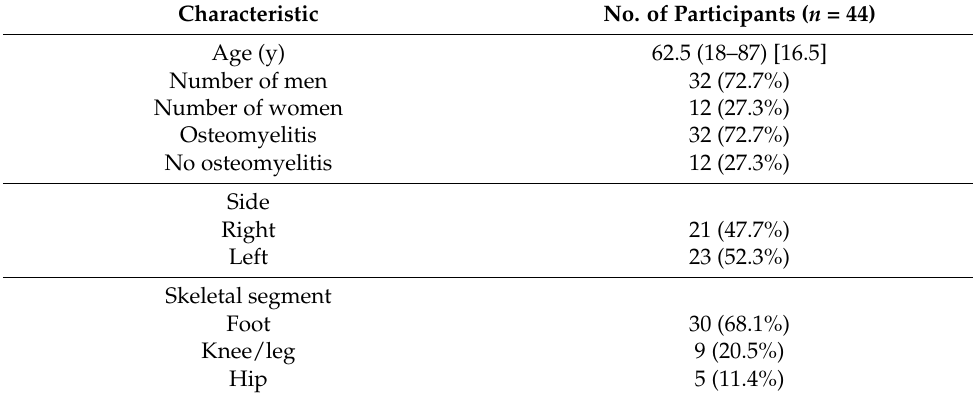
Table 1. Demographic and clinical data of the